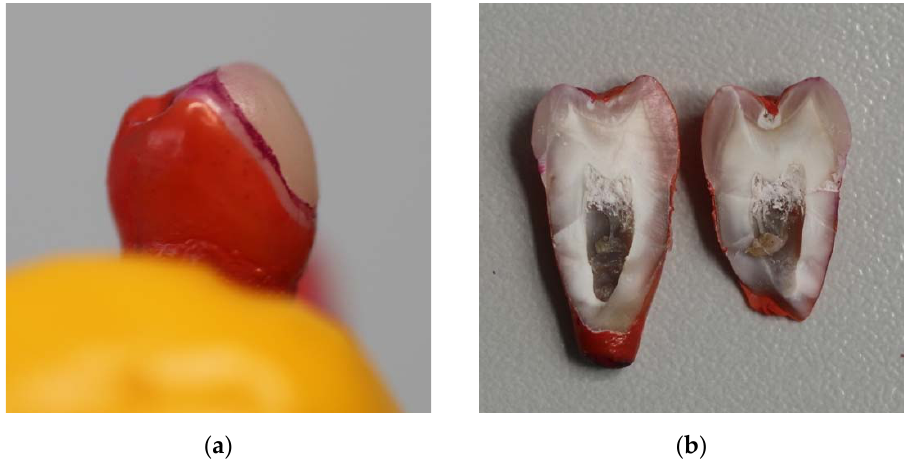
Figure 6. Specimen preparation and coloring: ( a ) teeth were immersed in 0.5% basic fuchsin dye for 24 h. After coloring, teeth were rinsed thoroughly under running water and polished with a polishing brush to remove the dye on the surface; ( b ) each specimen was sectioned at the center in facio-lingual direction with a 0.5 mm low speed diamond disk.